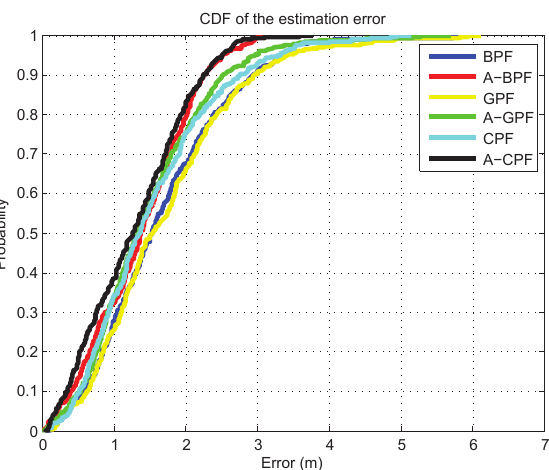
Figure 13. Overall cumulative distribution functions of particle filters (PFs) for both